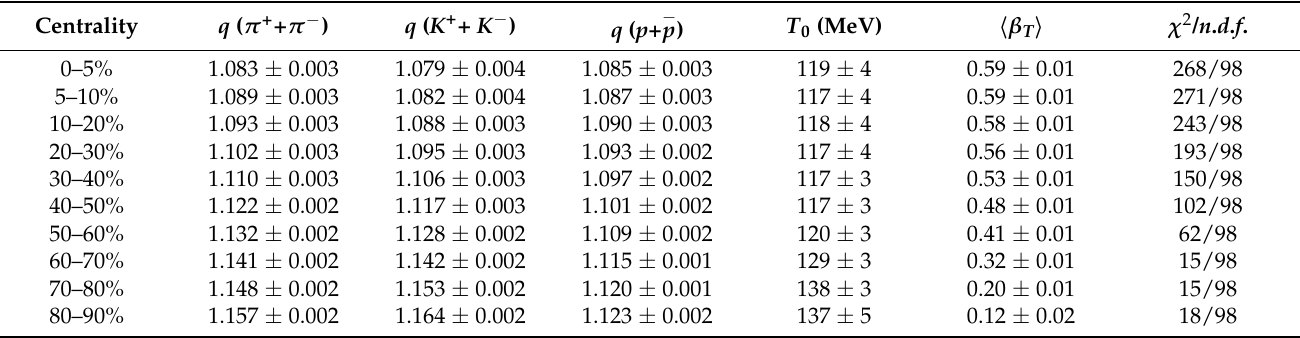
Table 3. The results of combined minimum χ 2 fits with thermodynamically non-consistent Tsallis function with transverse flow (Equation (4)) of p T spectra of particles in Pb + Pb collisions at √ s nn = 5.02